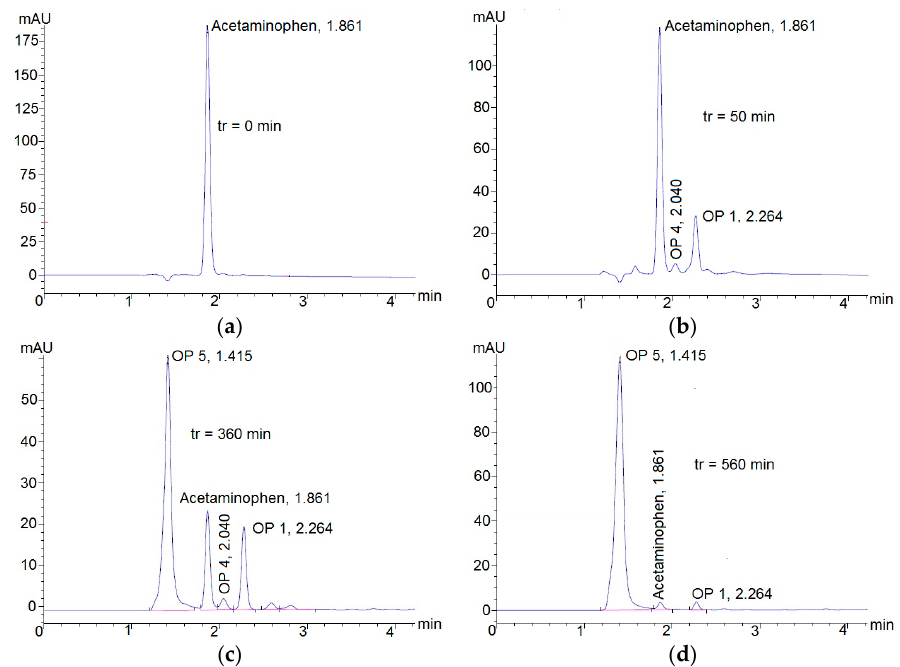
Figure 5. Chromatograms of acetaminophen degradation and its transformation products at different reaction times for the scenario involving pH 9 with a current density 9.5 mA/cm 2 . ( a ) tr = 0 min; ( b ) tr = 50 min; ( c ) tr = 360 min; ( d ) tr = 560 min. OP refers to oxidation products.